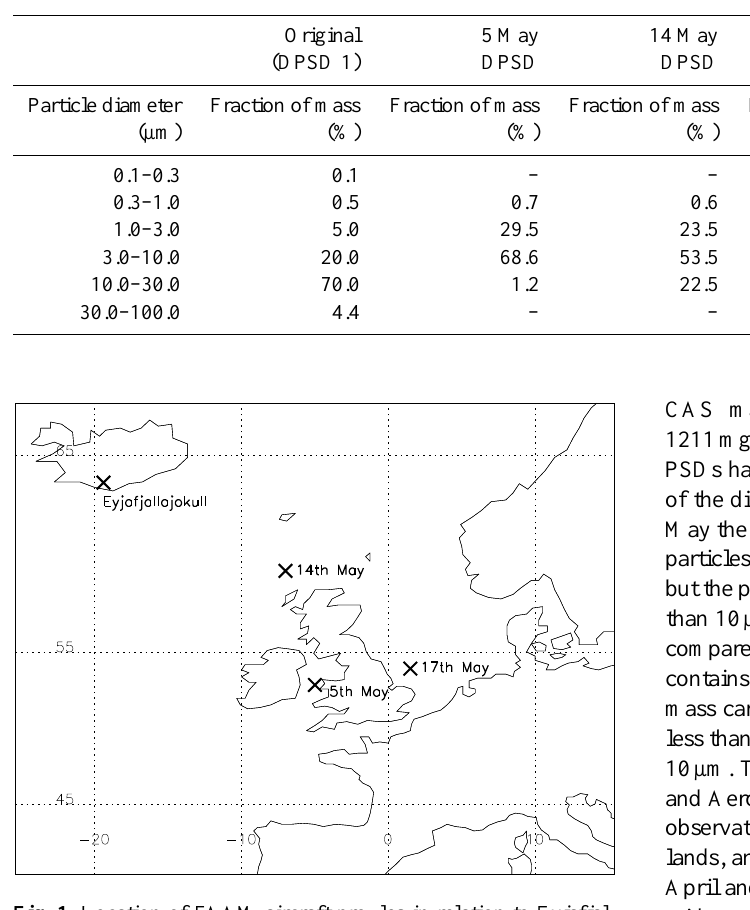
Fig. 2. (a) Observed column integrated mass and (b) Observed column integrated particle size distribution. 12 UTC on 5th May (dashed), 13 UTC on 14th May (dotted) and 15 UTC on 17th May (solid).